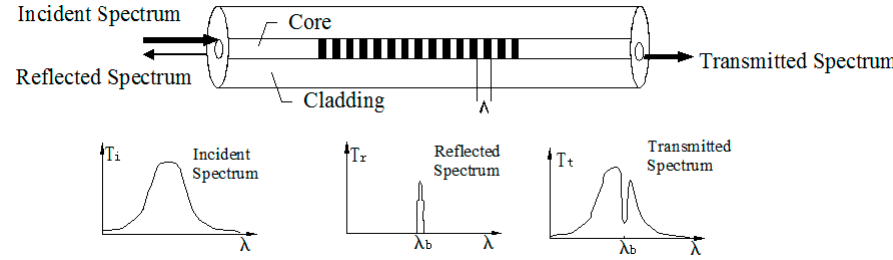
Figure 2. Working schematic of a fiber Bragg grating (FBG) sensor.